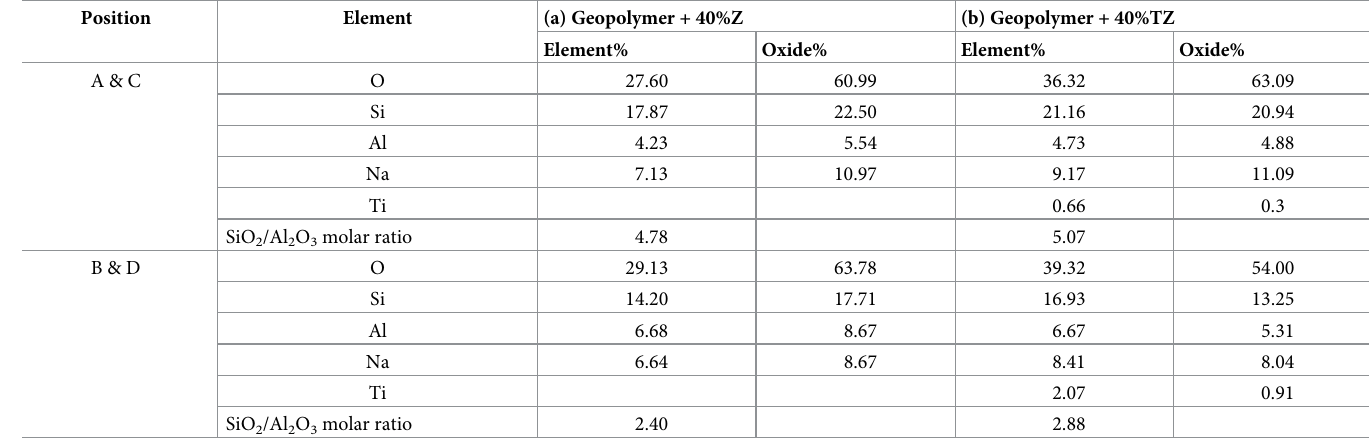
Table 2. Compositions of the elements and oxides from EDS in MK-based geopolymer with 40 wt% of (A) zeolite and (B) TiO 2 /zeolite. Position